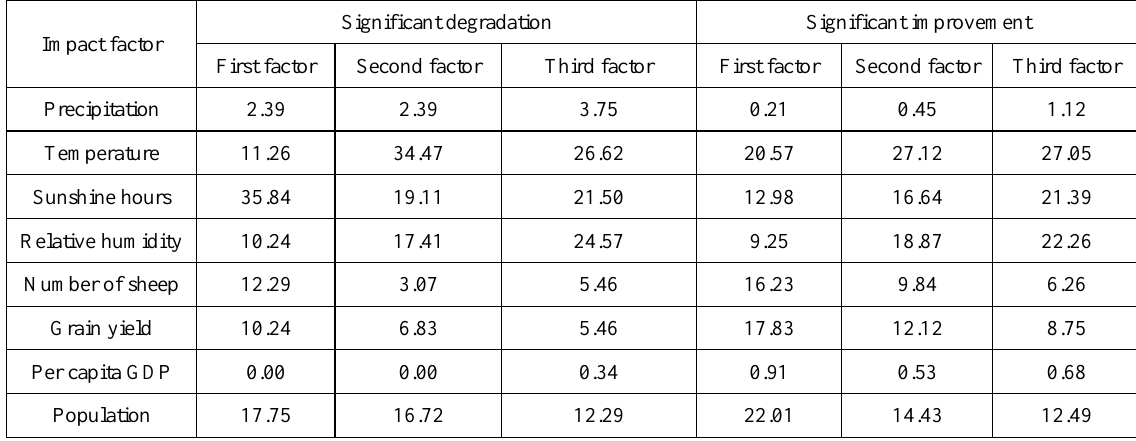
Table 2. Percentage of dominant factors in the area RUE significantly changing